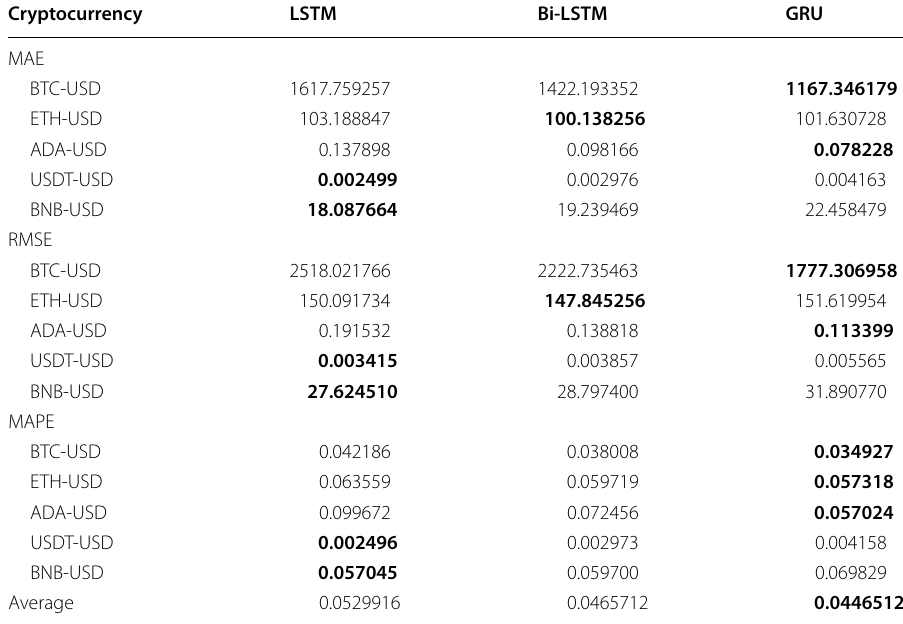
Bold value represents the lowest error score for each cryptocurrency pair